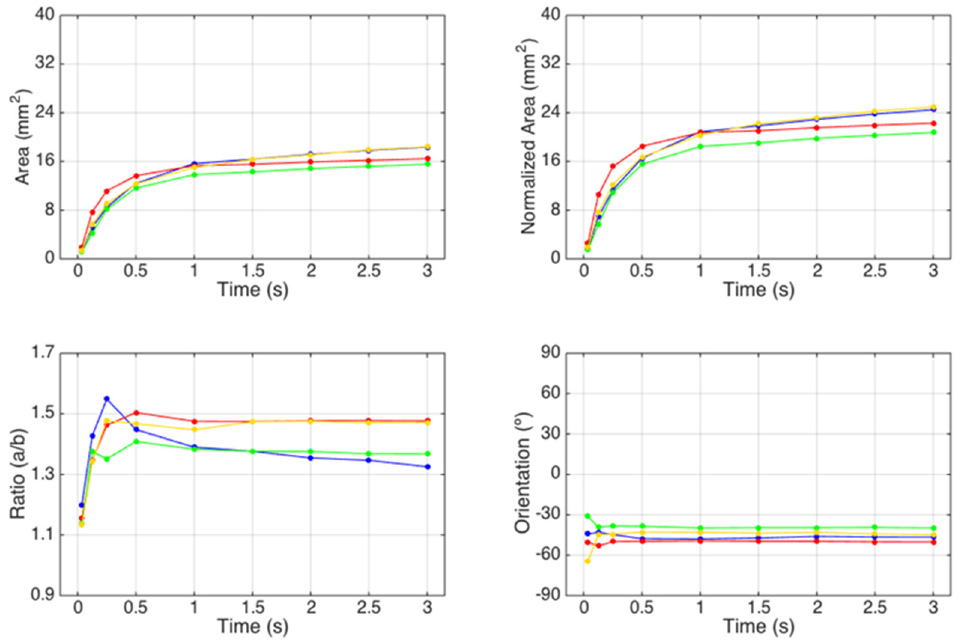
Figure 15. Comparative graphs of the spreading dynamics of a liquid droplet for the tissue-paper samples Bd sl (in blue), Bd rl (in red), Bm sd (in green), and Bm rd (in yellow).